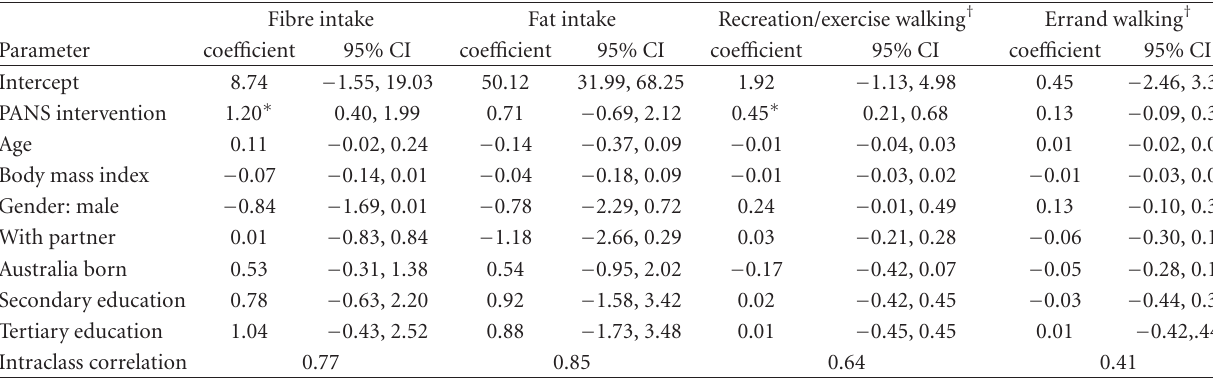
Table 3: Mixed regression analysis of outcomes before and after PANS